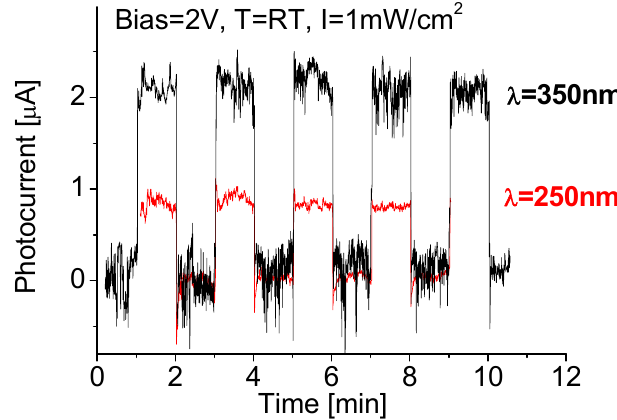
Figure 6. Responses of the device during cyclic tests with 2 min period at RT exposed to 250 nm and 350 nm UV radiations. RT—room temperature; λ : wavelength; B—bias voltage.